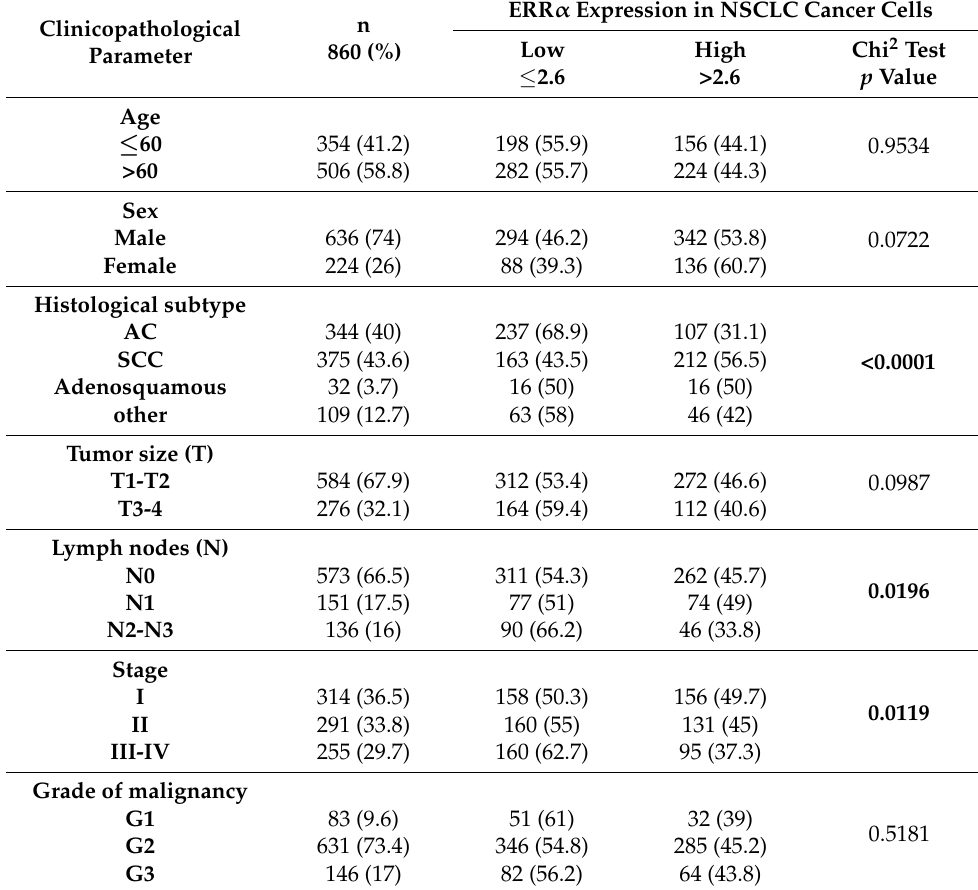
Table 2. Clinicopathological characteristics of patients with non-small cell lung cancer (NSCLC) related to low and high expression of ERR α (Chi 2 test analysis), significance in